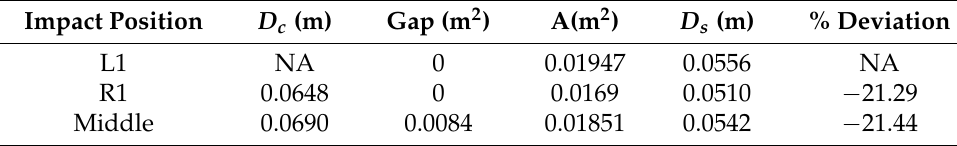
Table 5. Matrix sensor depth calculation for head-form impact